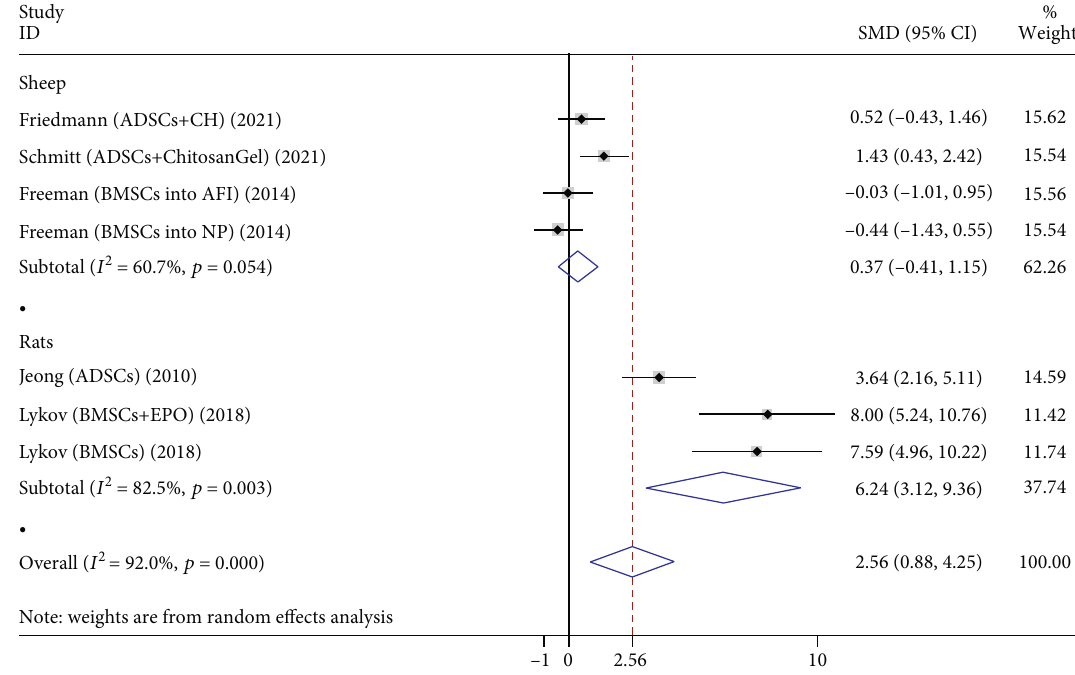
Figure 4: Forest plot showing the e ff ect of stem cell group and control group on disc height in animal